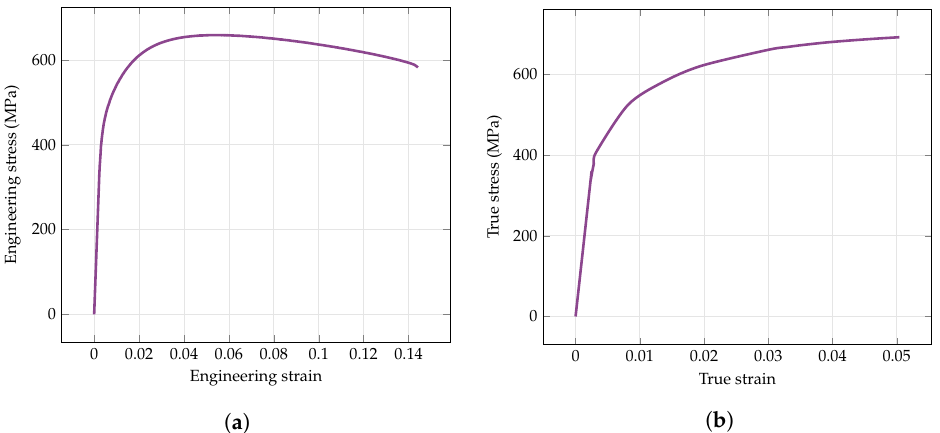
Figure 7. Monotonic tensile test results for the deposited bimetallic specimens: engineering stress- engineering strain ( a ) and true stress–true strain ( b ) curves. Table 5. Obtained mechanical properties of the bimetallic specimens, comprised of the substrate (AISI 1045) and deposited alloy (18Ni300).